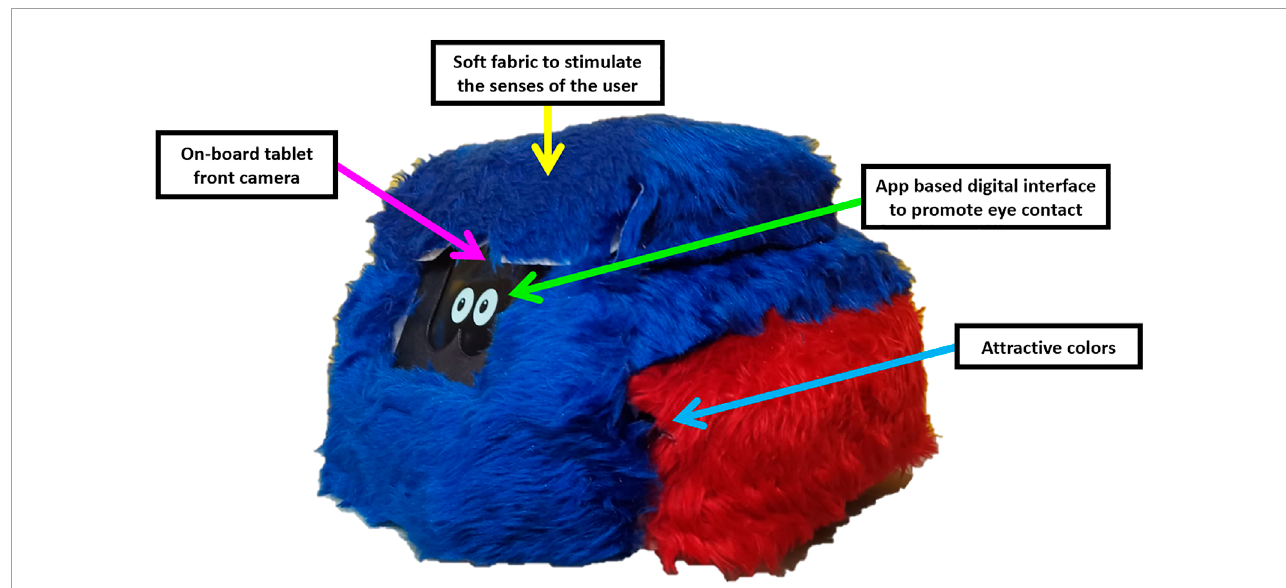
FIGURE 9 Final aspect of the proposed SAR platform. A bi-tone soft fabric cover was used to invite ASD users to establish physical contact with the SAR. Red and blue colors were selected for the cover. Also, an eye animation is projected on the onboard tablet screen, which serves as an indicator that all systems are running correctly. After its assembly process, the prototype of the SAR proposed in this work received the name of Autonomous Robot for Autism